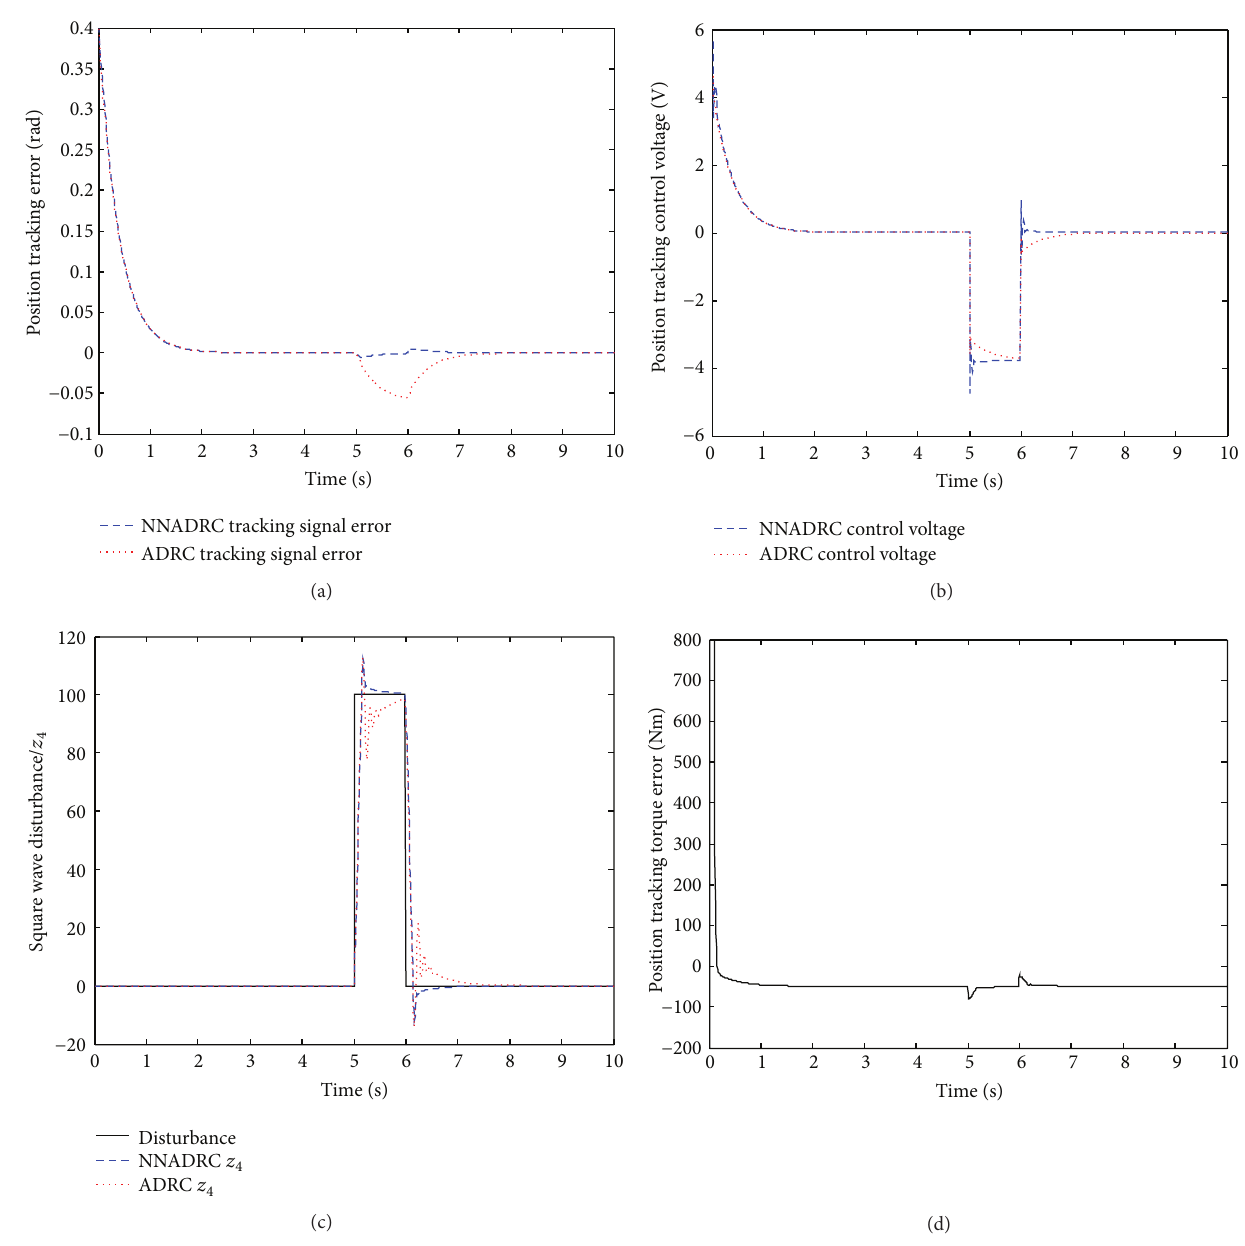
Figure 4: Step response of the control system: (a) errors of position signal with square wave disturbance, (b) position tracking control voltage, (c) square wave disturbance and the estimated z 4 , and (d) torque errors of position